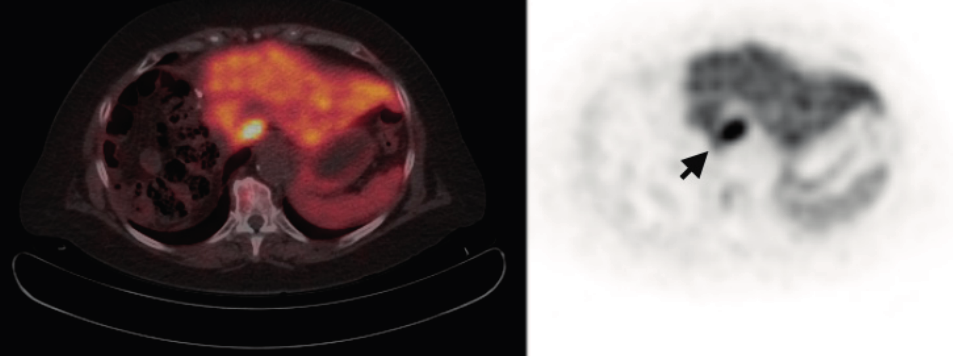
Figure 2. Recurrent HCC surrounding previous radiofrequency ablation site. PET/CT ( left ) shows absent FCh uptake ( white arrow ) in an area of the liver where HCC was previously treated by radiofrequency ablation. Corresponding PET ( right ) clearly shows multiple foci of increased FCh uptake surrounding the ablation site consistent with recurrent HCC ( arrows ). A pulmonary metastasis was also detected in this patient ( arrowheads ).